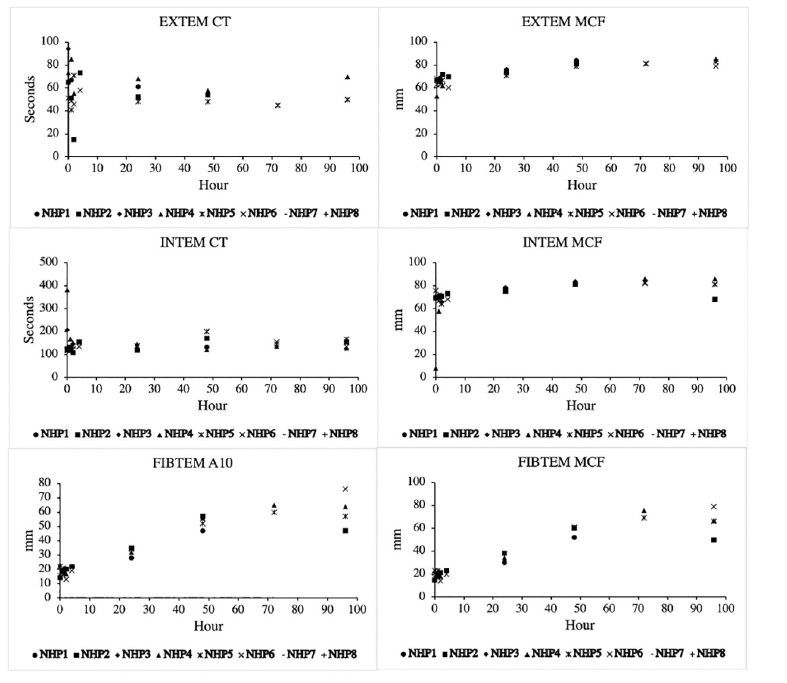
Fig 4. Selected ROTEM results. � denotes statistical significance from baseline values (p < 0.05).